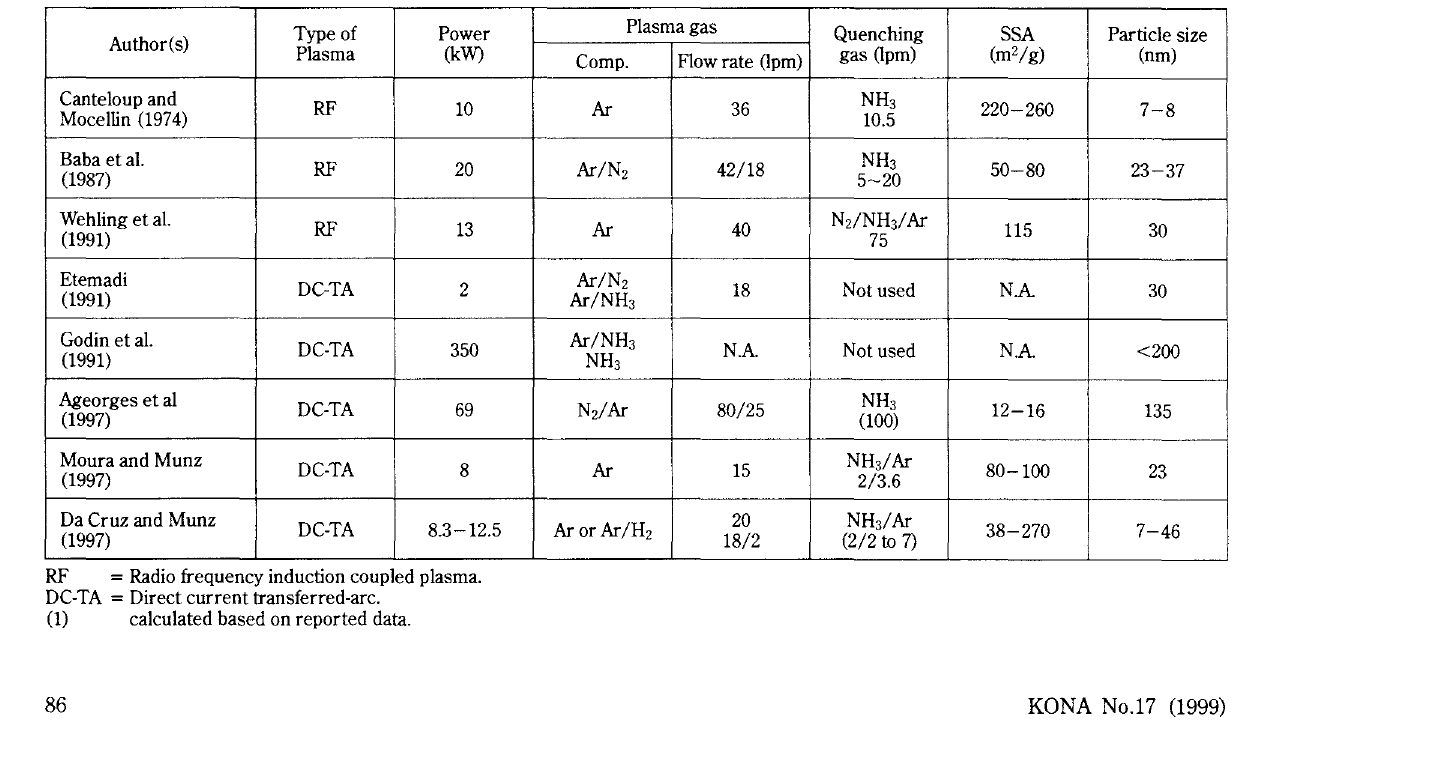
Table I Summary of experimental results reported in the literature for the plasma synthesis of